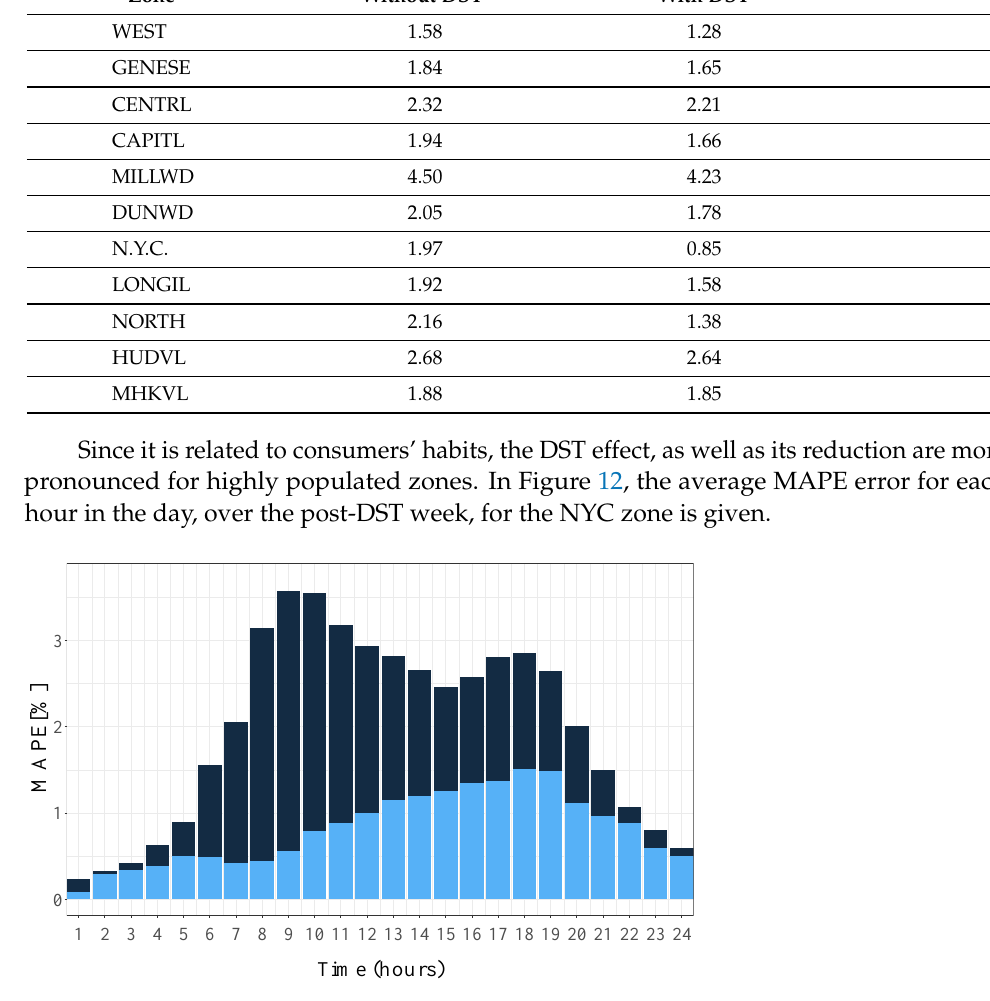
Figure 12. Average MAPE result for each hour in a day for the week after DST (NYC zone). The daylight saving effect is based on the clock change dates, with DST built into the annual and weekly profiles of a single load. However, when daylight information is more general approach to the DST